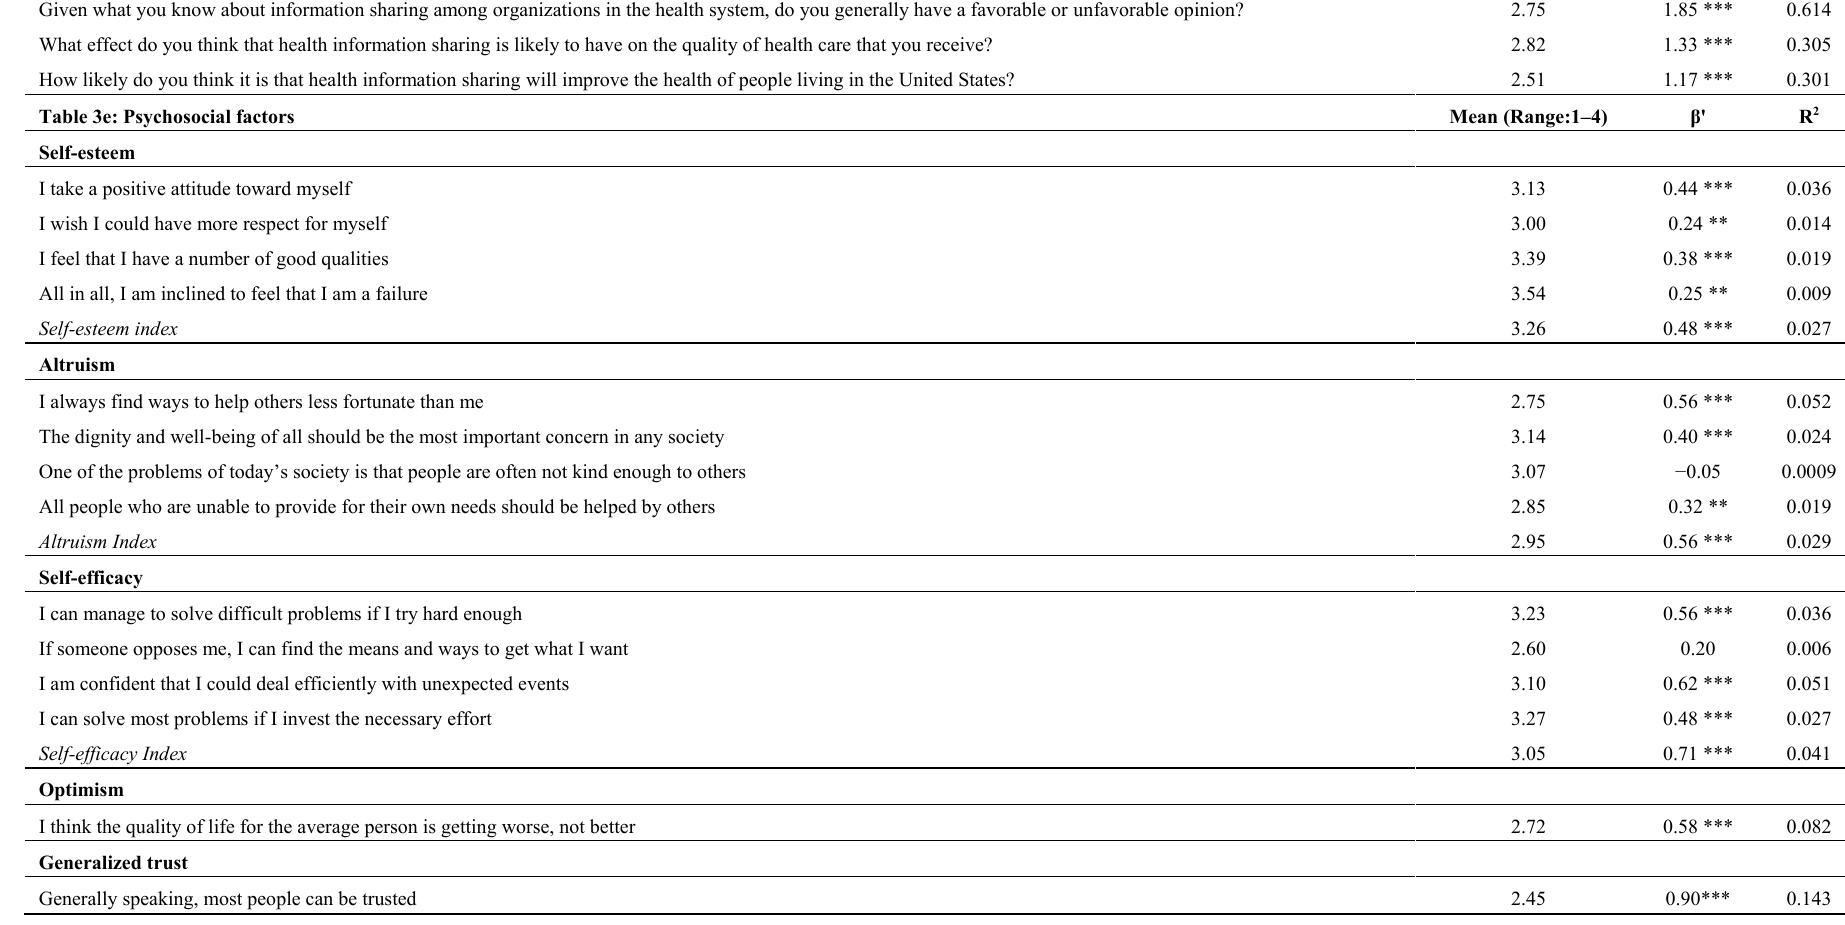
Table 3. Cont. Table 3d: Expectations of health information sharing Mean (Range:1–4)